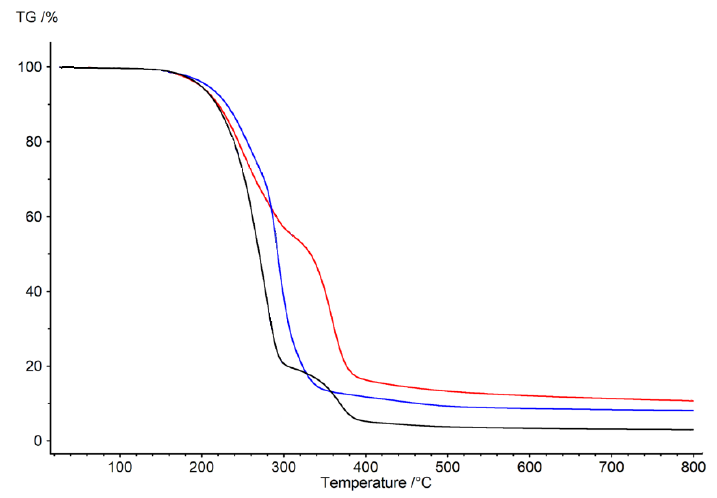
Figure 2. TG curves for membranes CTA-o-NPPE (black line); CTA-o-NPPE with 1–hexyltriazole before process (blue line) and CTA-o-NPPE with 1–hexyltriazole after process (red line).